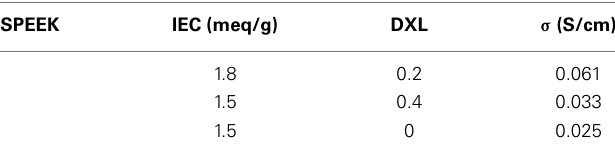
Table 3 | Conductivity values at 140°C and RH 90% for SPEEK samples with different DXL .